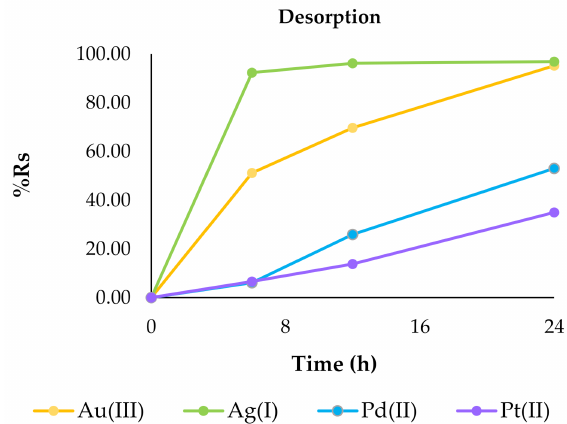
Figure 6. The sum of desorbed metal ions after 24 and 48 h. The given values of %R des carry ±